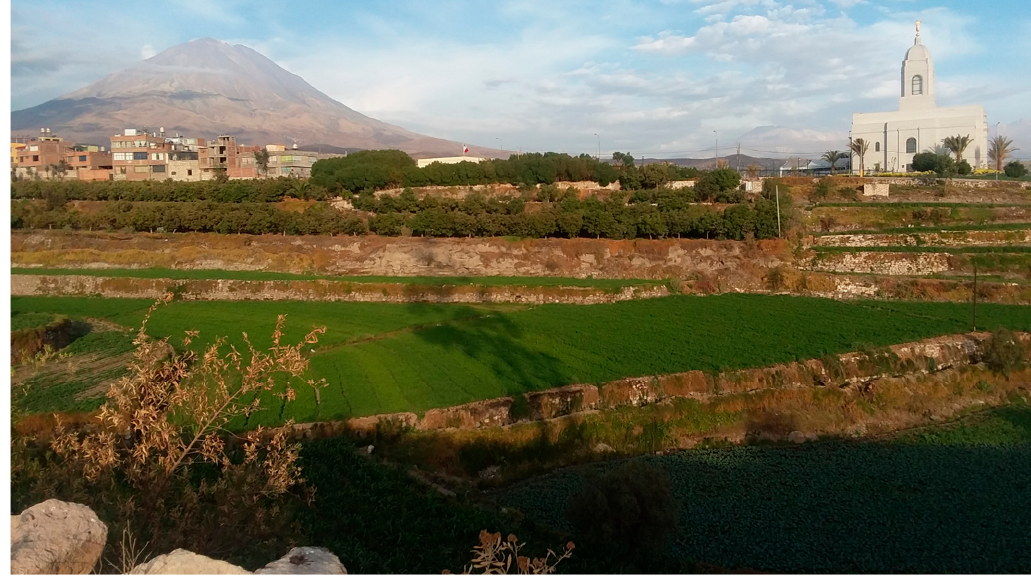
Figure 1. The Arequipa, Peru temple (right) is the house of the Lord for Mormons. It sits on the skirts of the volcano, Misti (left), a deity for many arequipeños . December 2019. 2